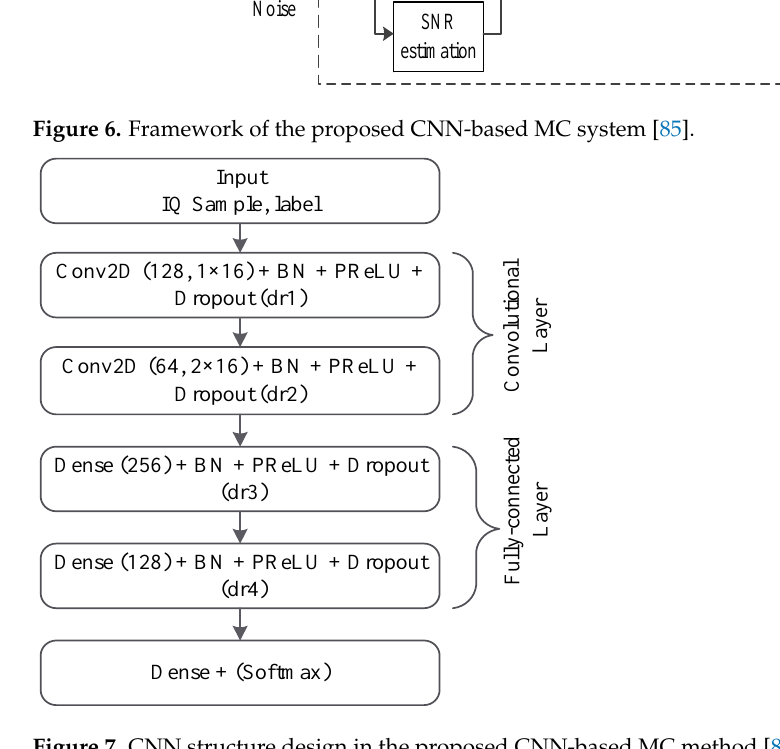
Figure 7. CNN structure design in the proposed CNN-based MC method